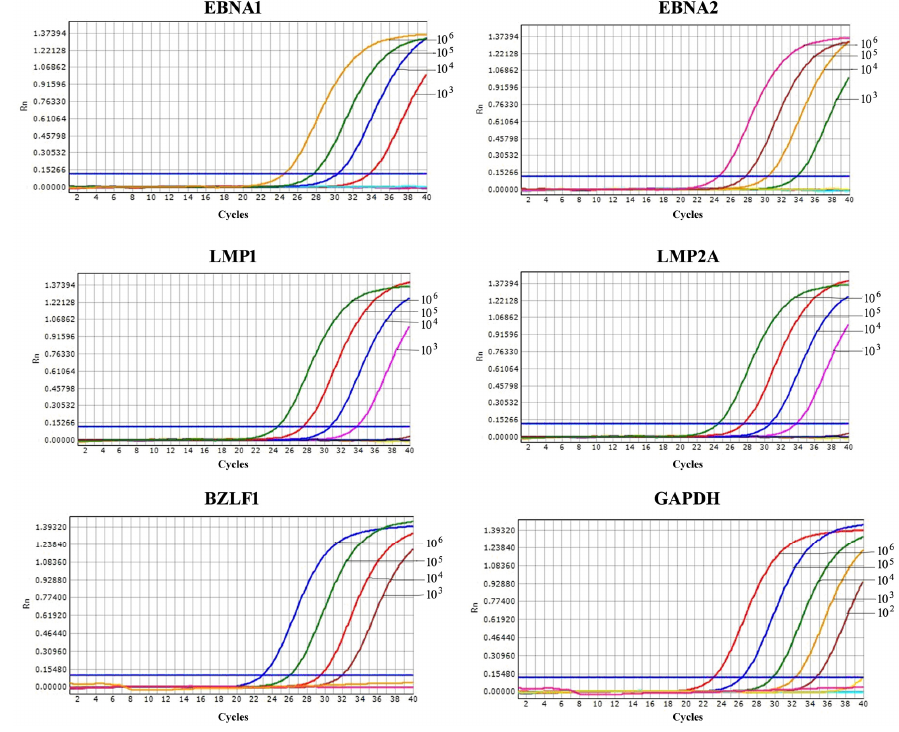
Figure 4. Sensitivity of RT-qPCR for the evaluation of EBV latent transcripts (EBNA1, EBNA2, LMP1 and LMP2A), a lytic transcript (BZLF1) and GAPDH. The sensitivity of RT-qPCR was determined using cell mixtures containing 1 × 10 6 BJAB cells and 10-fold serial dilutions of Raji cells ranging from 10 6 to 10 0 cells, untreated or treated with TPA. 10 6 –10 0 : 10 6 to 10 0 Raji cells out of 1 × 10 6 BJAB cells. The detection limits were 10 3 , 10 3 , 10 3 , 10 3 , 10 3 , and 10 2 Raji cells out of 1 × 10 6 BJAB cells for EBNA1, EBNA2, LMP1, LMP2A, BZLF1 and GAPDH, respectively.